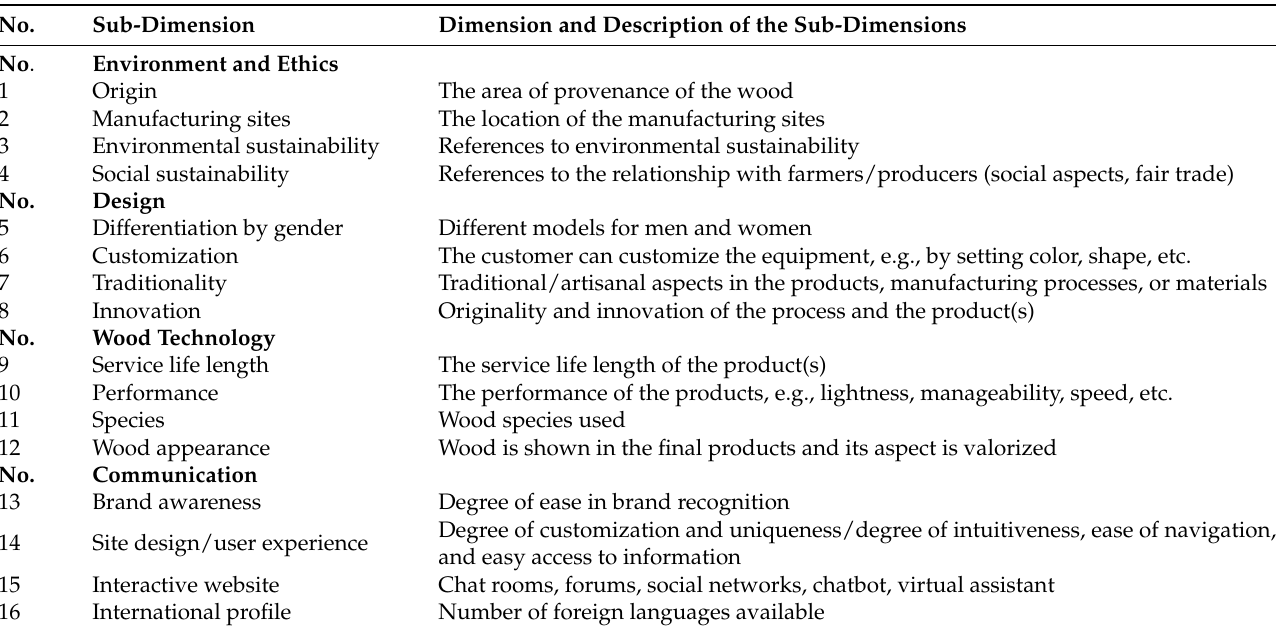
Table 1. Analyzed dimensions and